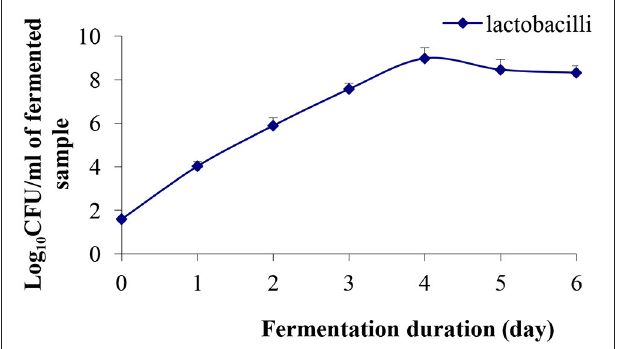
FIGURE 1 | Evolution of lactobacilli population during the course of fermentation. Results are presented as mean ± SD ( n = 3).